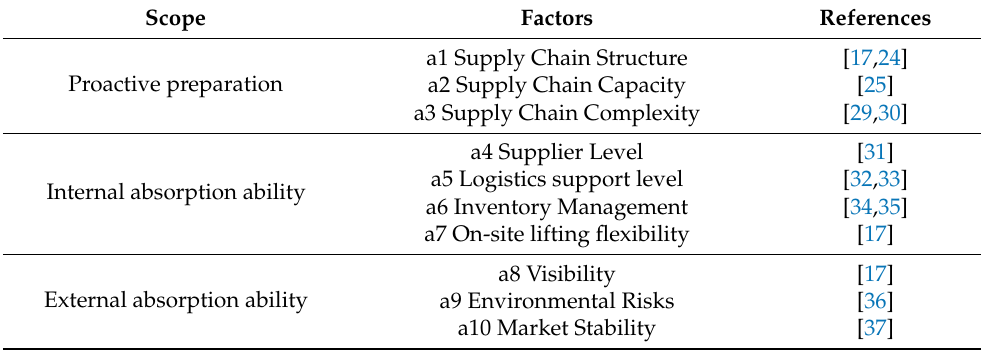
Table 1. Influencing factors system of prefabricated buildings supply chain